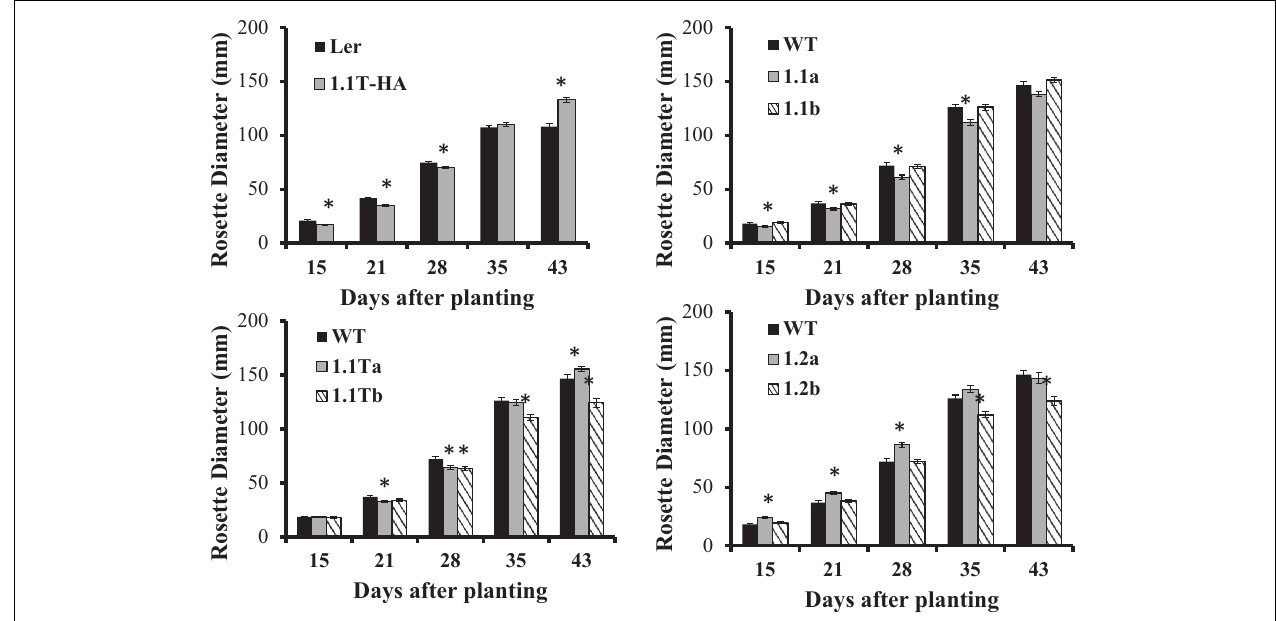
FIGURE 9 | Rosette Diameter Measurements. Rosette diameter of soil-grown plants grown under long day conditions for the indicated number of days. Means ± SE are presented. ∗ p -value ≤ 0.05 when compared to the wildtype control.